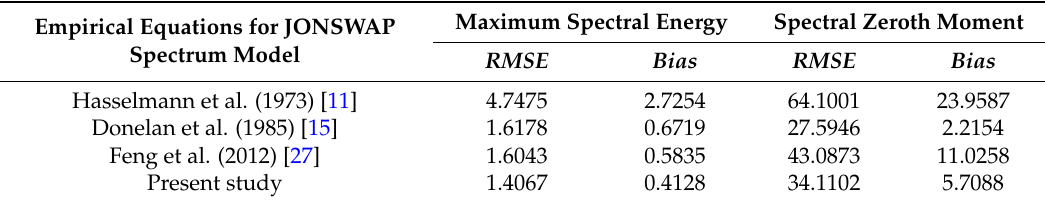
Table 13. The comparisons of wave energy estimation using different empirical equations under normal